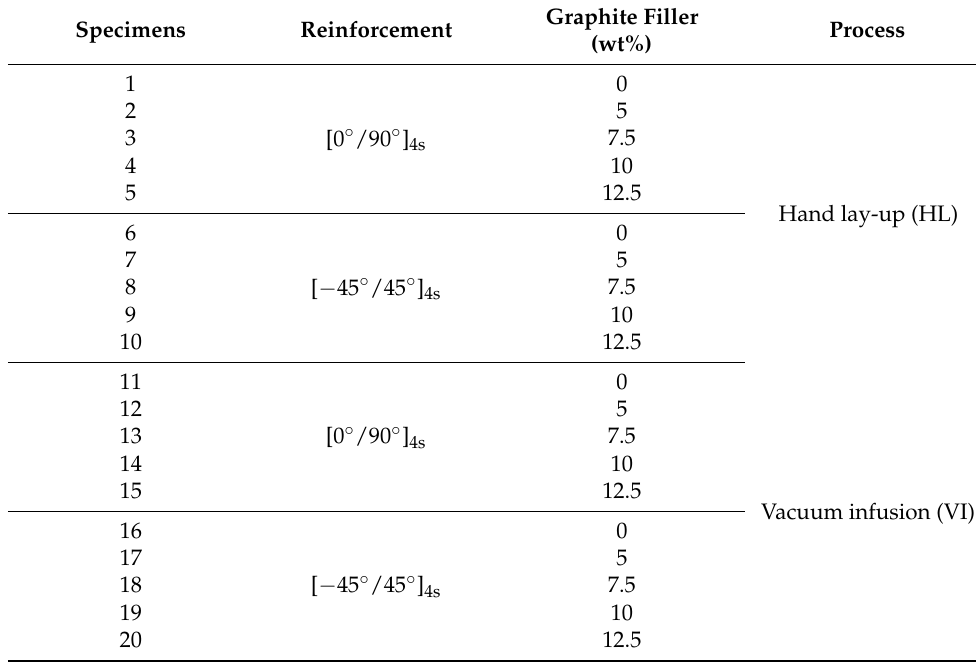
Graphite Filler